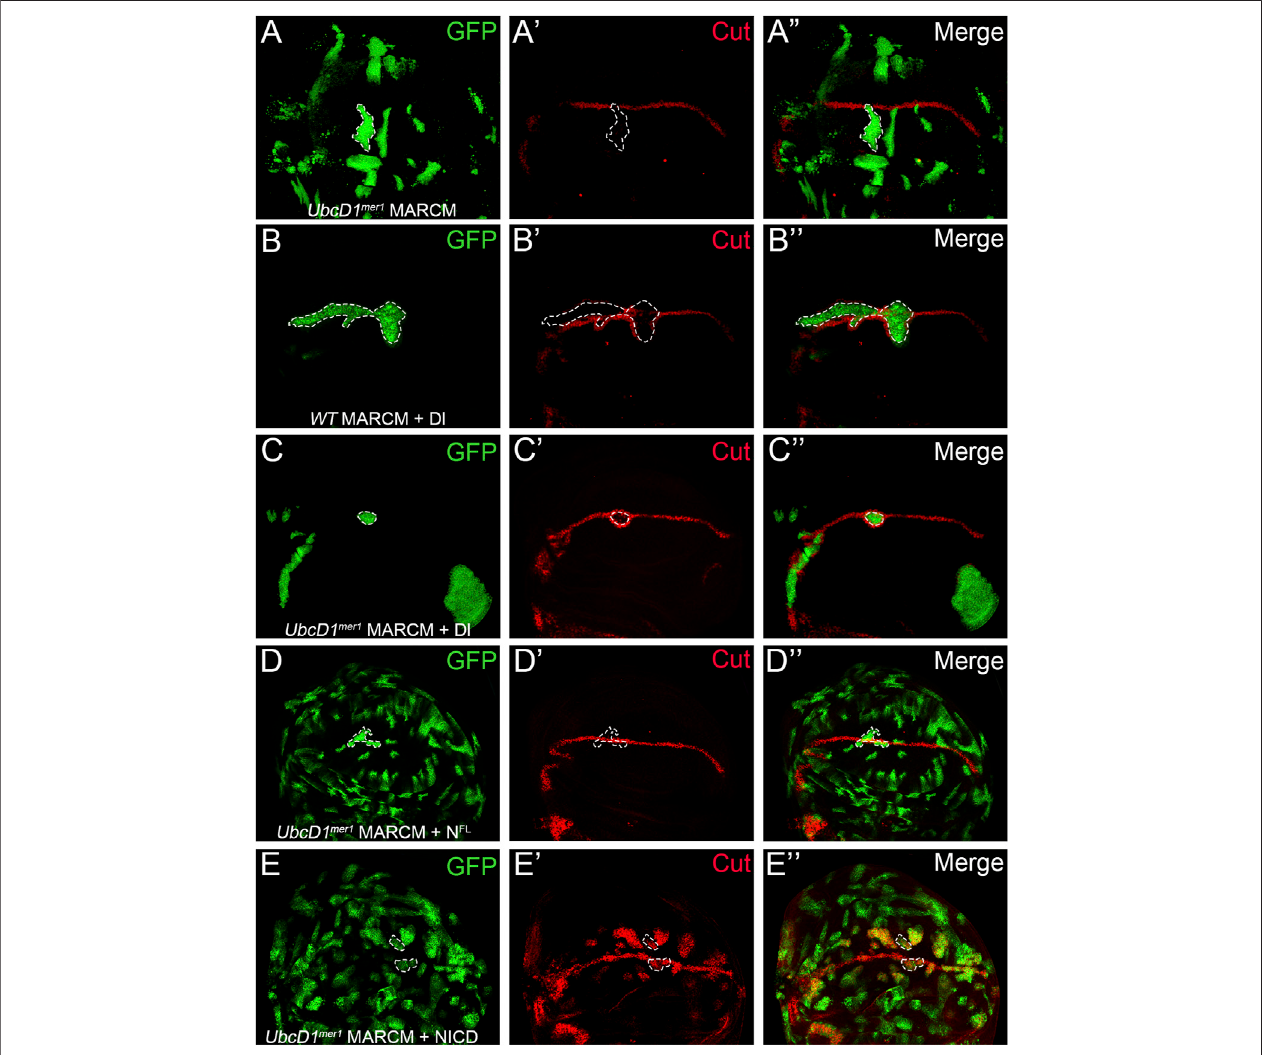
FIGURE4| UbcD1functionsupstreamofNotch proteinprocessing. (A) In UbcD1 mer1 MARCMclones,theexpression ofCutarereduced. (B – C) Over-expression of Dl in both wild type (B) and UbcD1 mer1 mutant cells (C) result in induction of Cut in cells surrounding the MARCM clone. (D) The full-length Notch protein restores